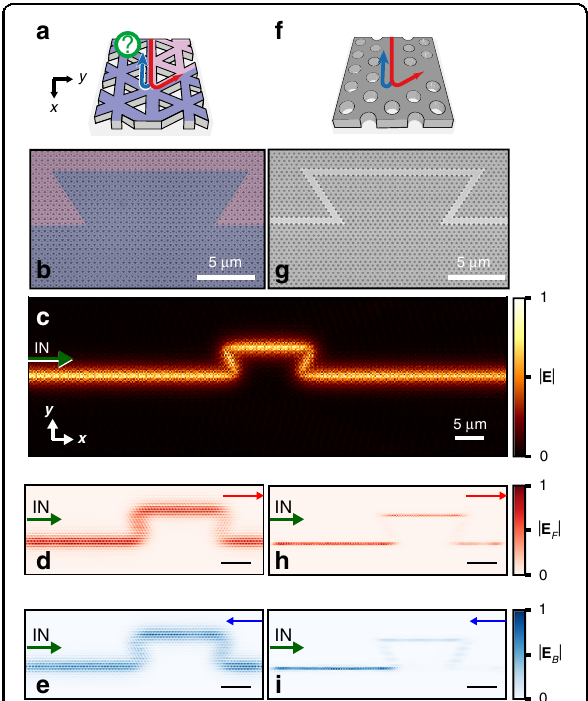
Fig. 4 Degree of topological protection. a Schematic of the mode contributions in a Ω -shaped defect VPC waveguide. Red arrows indicate the forward-propagating modes, with F 1 and F 2 denoting the modes before and after the defect, respectively. Blue arrows indicate backward-propagating modes before ( B 1) and after ( B 2) the defect. Yellow dashed circles show the locations of in- and out-coupling facets. White dashed circles indicate the four 120° corners. b Plot of the transmission coef fi cient η T , with the inset demonstrating transmission over a small region ([189.5 THz – 190.5 THz]). c Backward/ forward energy ratio before ( η R 1 ) and after ( η R 2 ) the Ω -shaped defect in the VPC domain wall. The inset shows how the back-propagation energies before and after the defect are almost indistinguishable over the considered frequency range. d and e show the corresponding plots of b and c for the W1 waveguide,